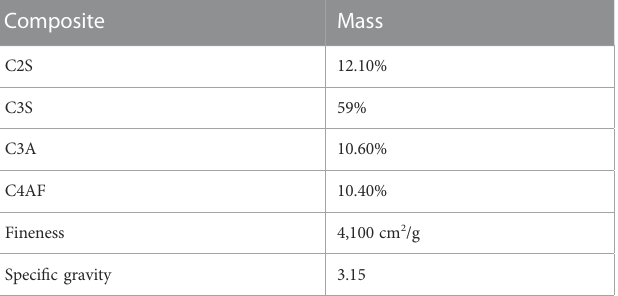
TABLE 2 Physical characteristics of cement.